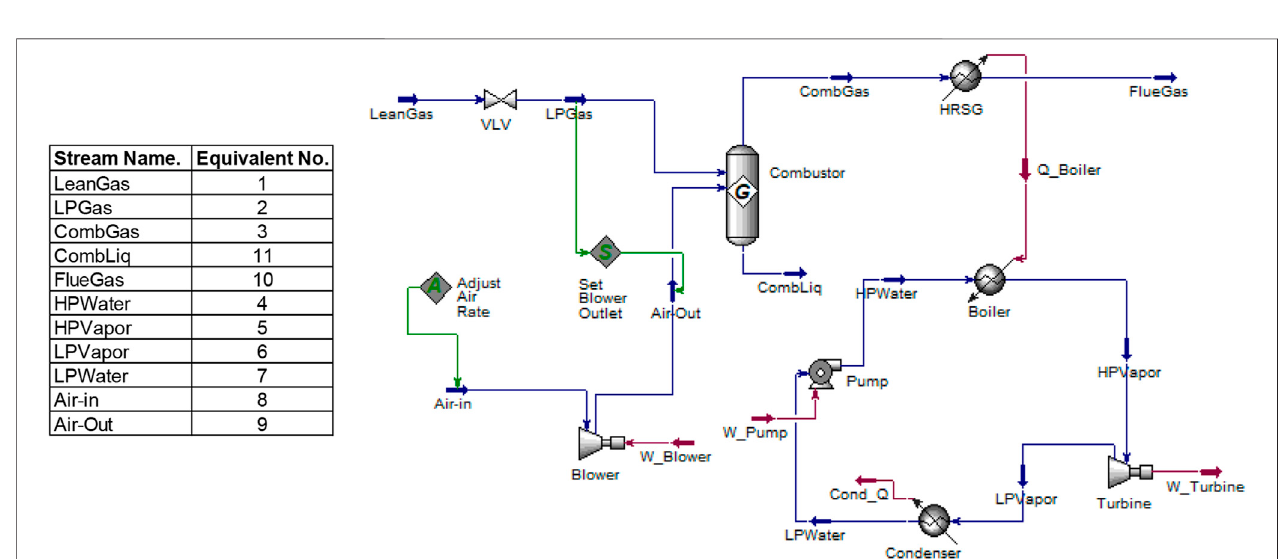
FIGURE 3 | HYSYS modeled natural gas liquefaction recovery plant process.